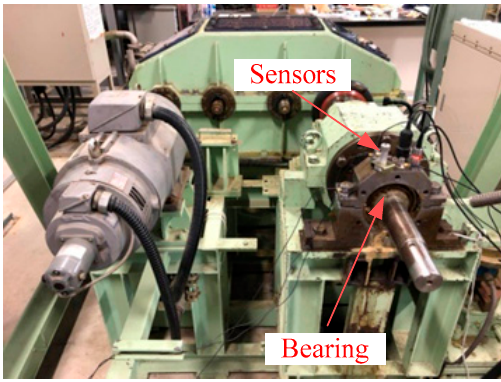
Figure 14. Bearing fault diagnosis experimental system.